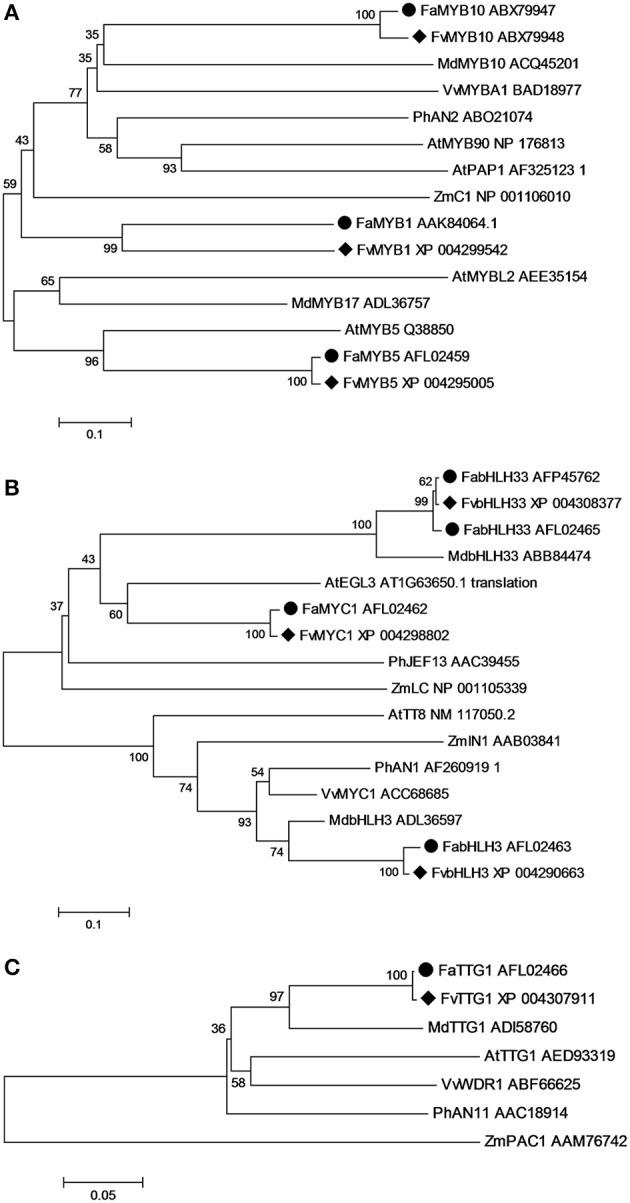
Phylogenetic relationships of homologous putative transcriptional regulators involved in anthocyanin biosynthetic pathway from Arabidopsis, Malus x domestica, Petunia x hybrida, Zea mays, Vitis vinifera, and Fragaria. Protein sequences of MYB (A), basic helix-loop-helix (bHLH) (B) and TTG1-like WD40 (C) were analyzed using MEGA 6.06 and the Neighbor-Joining method with 1000 bootstrap replicates. ♦ indicates genes from F. vesca and • indicates genes from F. ananassa.